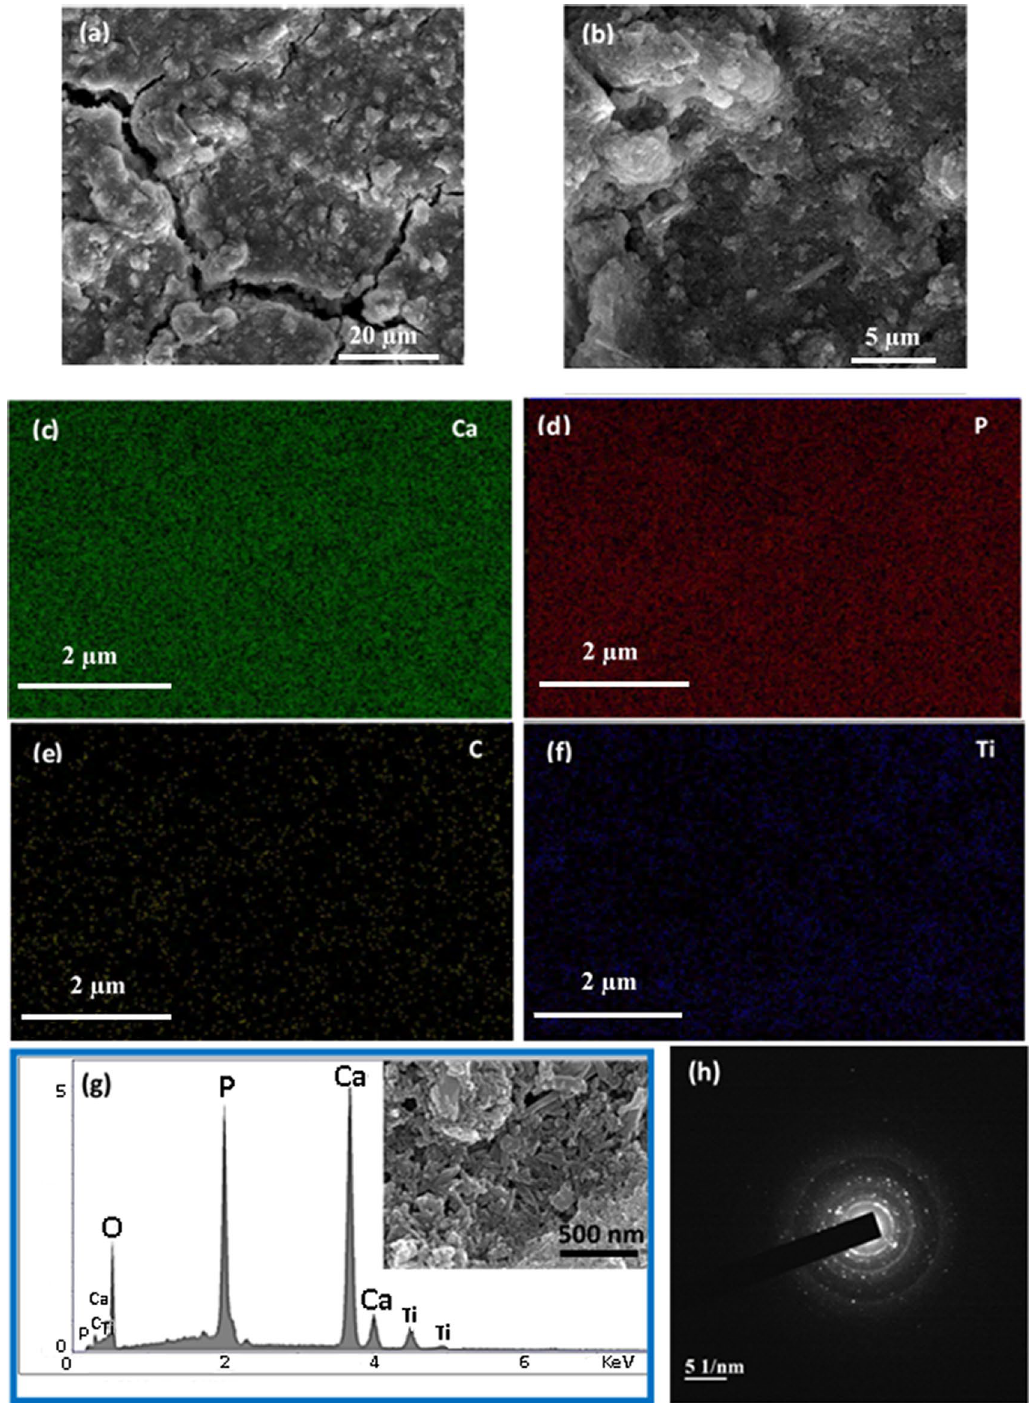
Figure 5. ( a , b ) SEM views at 20 µm and 5 µm magnifications, respectively; ( c – f ) EDX elemental mapping; ( g ) elemental composition of nanocomposite (the selected area is embedded in the EDX); and ( h ) SAED. Pictures show the S3.0